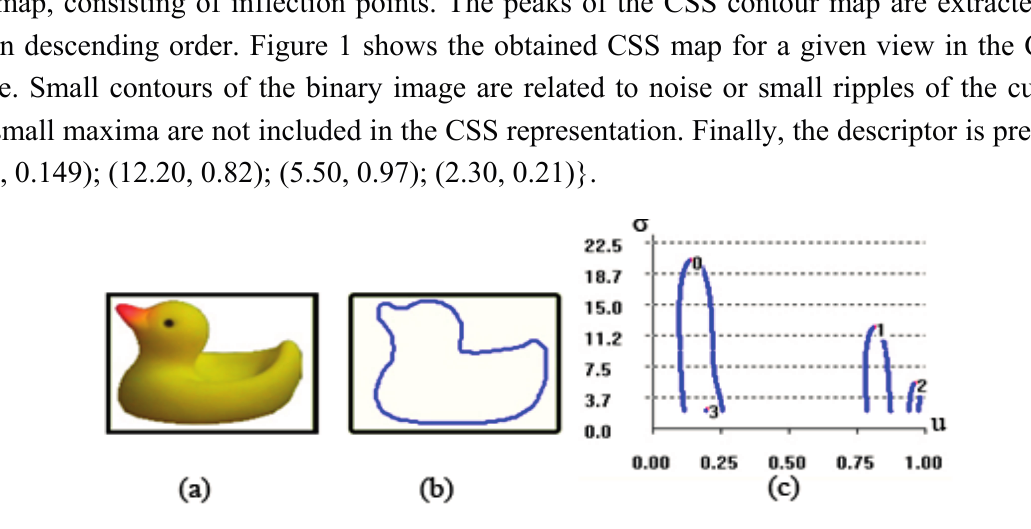
Figure 1. ( a ) Example of view from COIL-100 database; ( b ) its contour; ( c ) and its curvature scale space (CSS) image in the (u, σ )